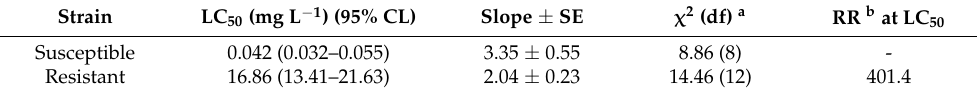
Table 1. Toxicity of chlorantraniliprole to two strains of Plutella xylostella.